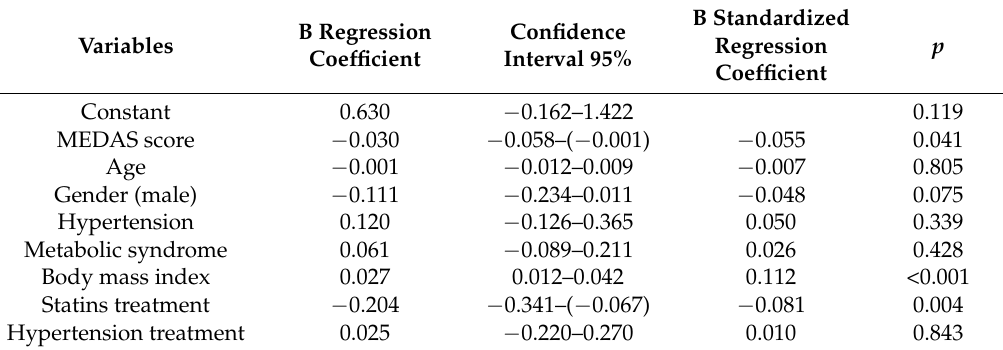
Table 2. Multivariable linear regression model to evaluate the association between C-reactive protein concentration and Mediterranean Diet Adherence Screener (MEDAS)